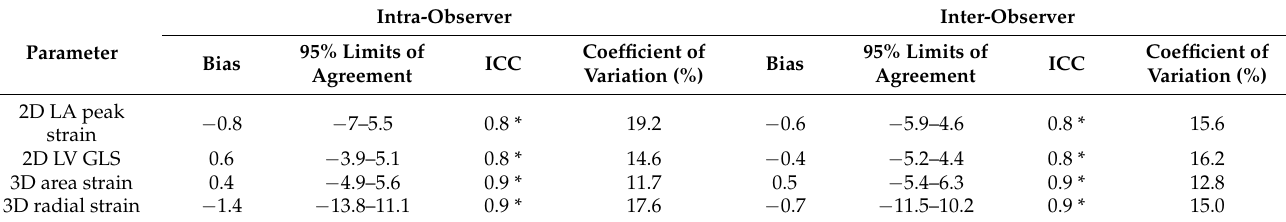
Table 5. Inter- and intra-observer variability of 2D LA, LV, and 3D LV strain